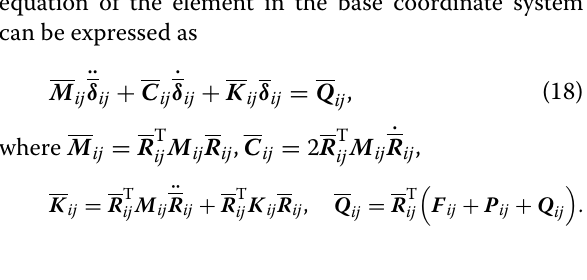
(a) Element generalized coordinates in link coordinate system